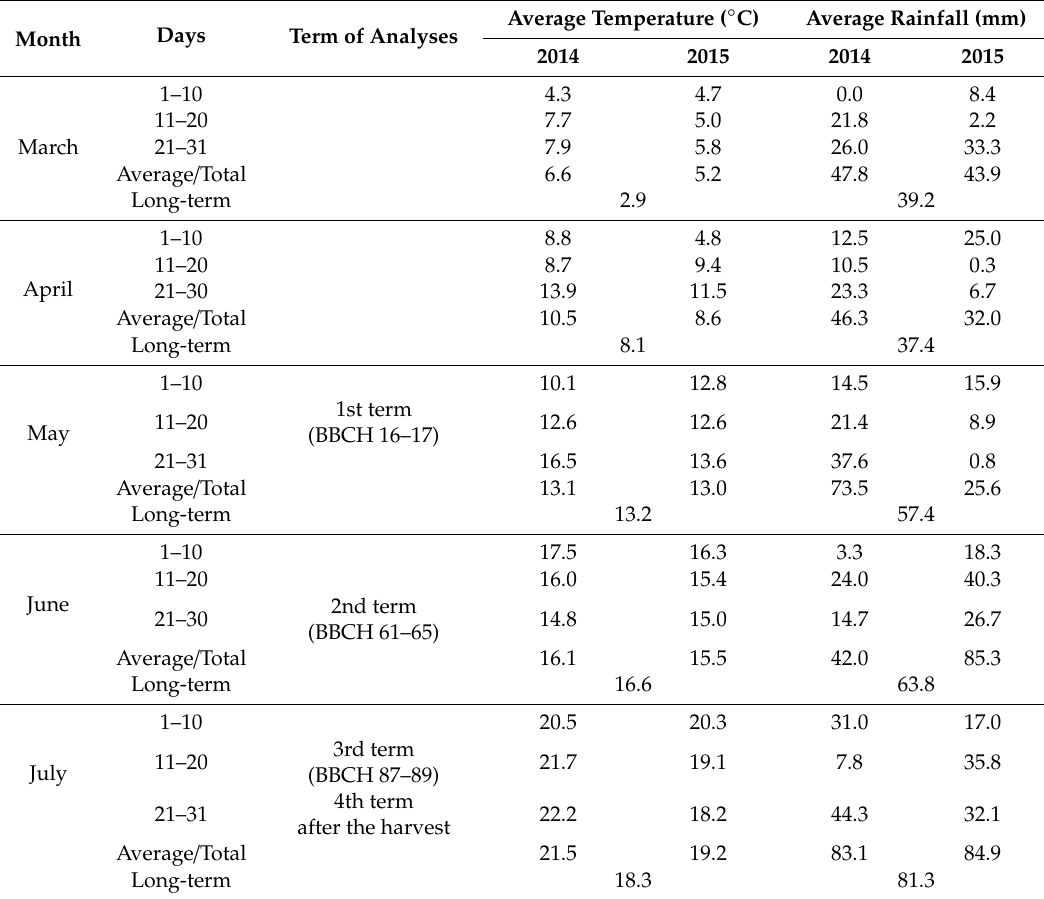
Table 2 denotes the temperature and rainfall during the experiment. The data were correlated with the microbiological parameters of soil, such as the biochemical activity and the count of microorganisms in various treatments of the experiment. Table 2. The weather conditions during the experiment. BBCH = biologische, bundesanstalt, bundessortenamt and